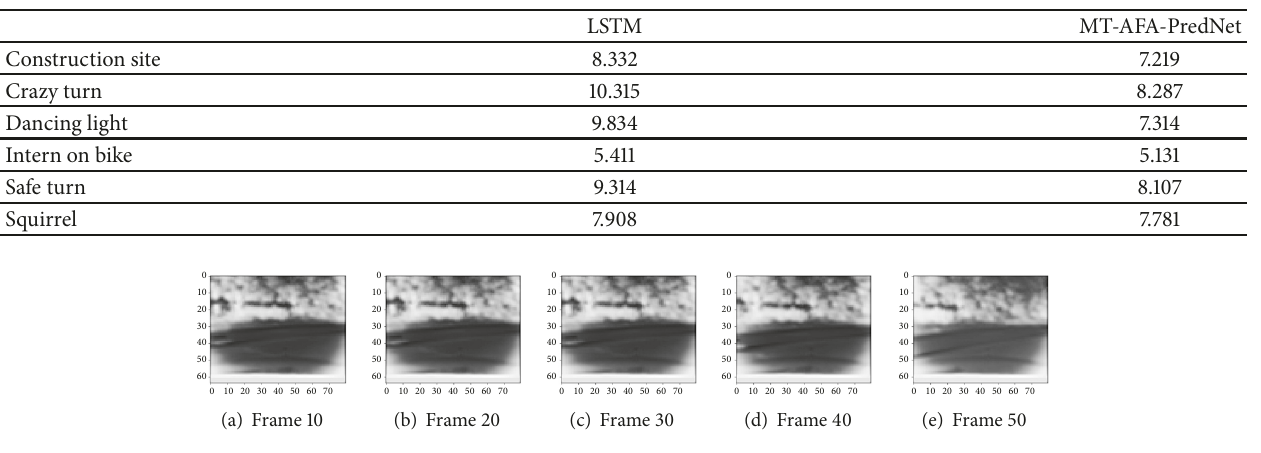
Table 3: RMS between LSTM and MT-AFA-PredNet.